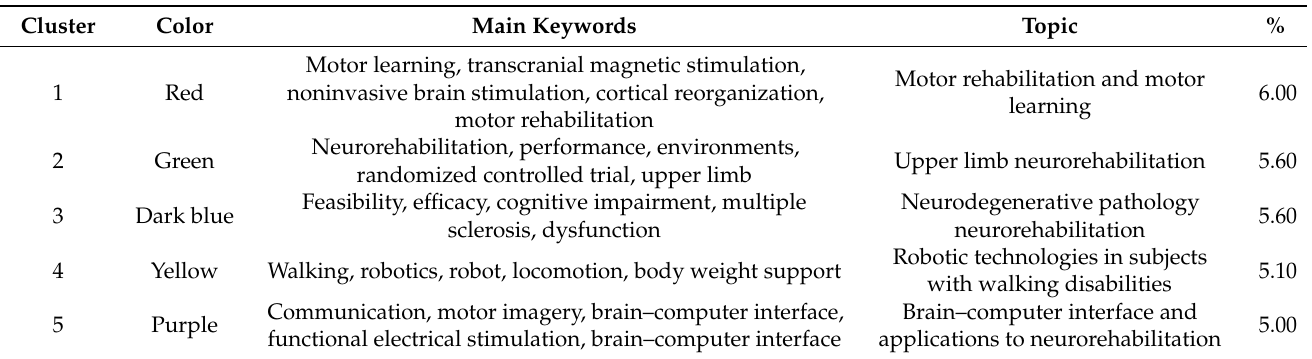
Table 3. Details of most frequent